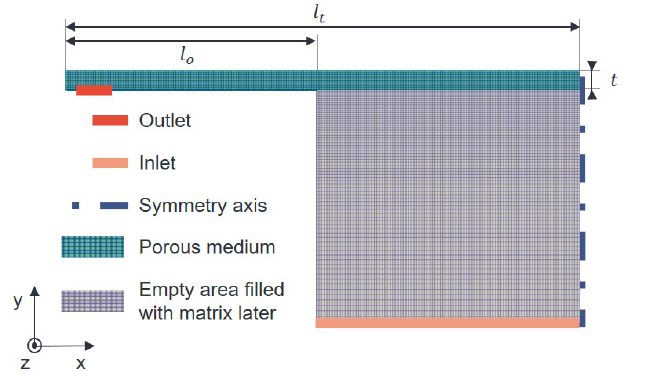
Figure 4. Mesh for the simulation